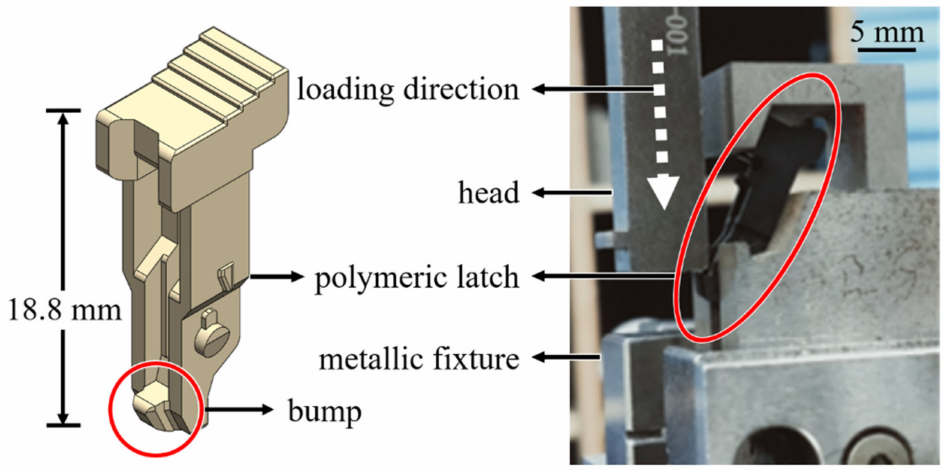
Figure 1. An experimental set-up for the measurement of the strength of the latch of DDR4 connector. Two types of the electronic connector, PCIE (with a PA4T housing) and SSD (with a LCP housing) as shown in Figures 2 and 3, respectively, were chosen for the investigation of the retention force here. A schematic diagram of experimental set-up for measurements of the retention force is displayed in Figure 4. The terminal gripped by a clamper was withdrawn from the polymeric housing at a constant velocity of 0.83 mm/s, which was numerically converted into the resulting representative strain rate level of one-tenth per second. Two strain rate levels (0.001 and 0.1 1/s) applied to the cylindrical specimen under the uniaxial compression test mentioned above thus reasonably correlate to the current experimentally investigated strain rate regime. Corresponding forces detected by a load cell attached to the clamper were then recorded (with five repetitions). A flowchart providing logical relationships among the above three experiments is shown in Figure